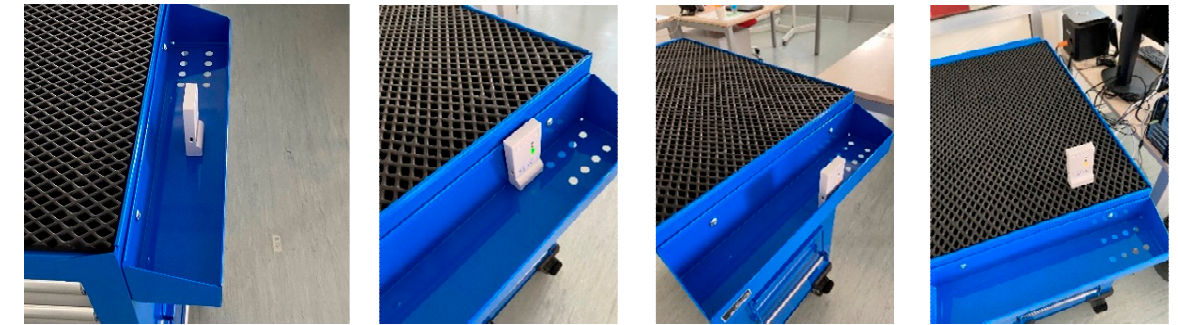
Figure 5. Positions of the moving tags ( middle , internal , external , above ).